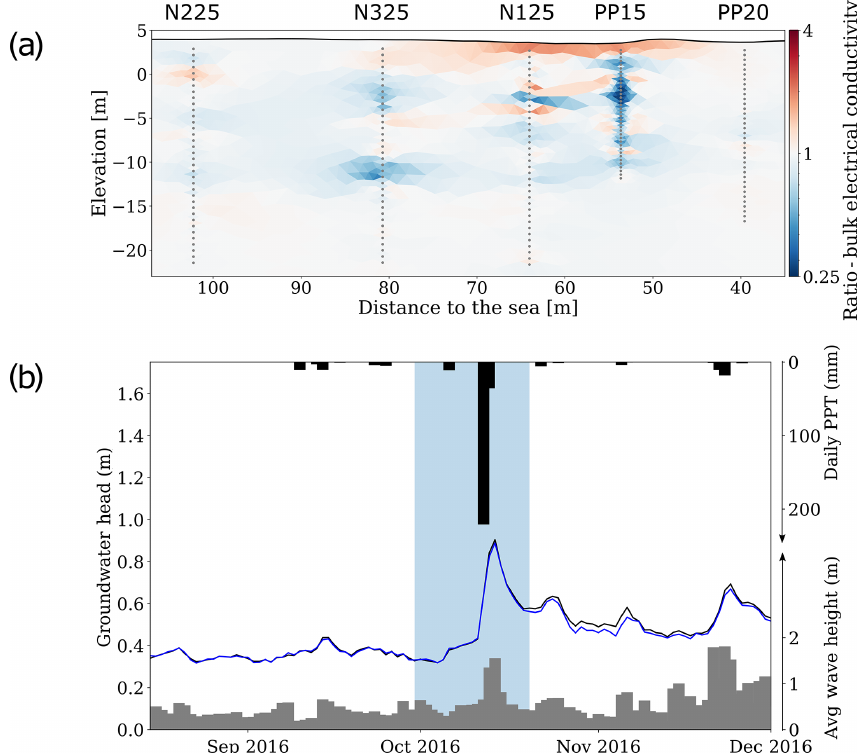
Figure 8. (a) Ratio between the bulk electrical conductivity model of 30 September and 21 October 2016. The heavy rain occurred on 12 October 2016. The image shows a decrease in conductivity in the unconfined and semiconfined aquifer and a conductivity increase in the unsaturated zone on both sides of nest N1. The decrease in conductivity observed along borehole PP15 is attributed to freshwater infiltration due to borehole construction. (b) Time series of groundwater level in boreholes N115, average significant wave height (gray bars) and precipitation (black bars). Highlighted is the heavy rain event of 220mm that occurred on 12 October 2016. The event was accompanied with an increase in groundwater level and in significant wave